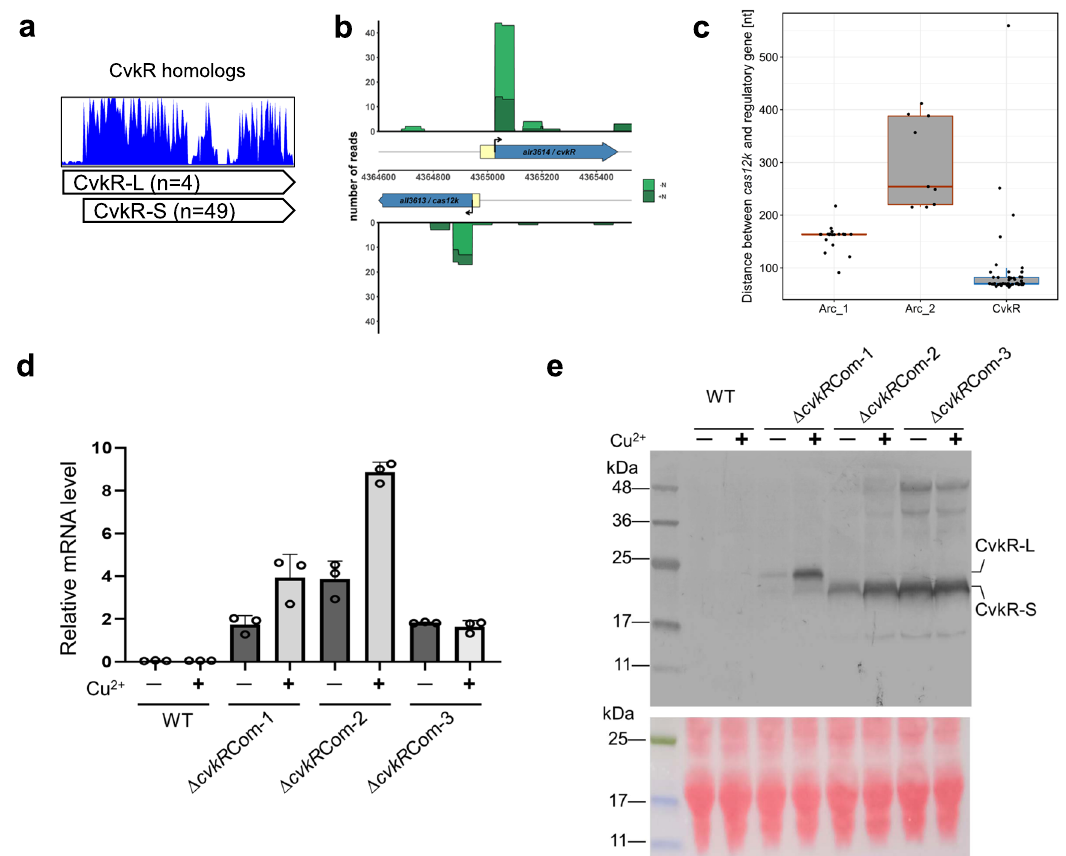
Fig. 3 | Leaderless expression of cvkR genes. a Deduced amino acid sequence alignment of 53 MerR-family CvkR homologs. The sequences of the MerR-family CvkR homologs for the multiple sequence alignment were recovered from public databases and are available in Supplementary Data 1. The sequences were aligned using MAFFT 87 and visualized with UGENE 88 . b Differential RNA sequencing data 28 indicate that the TSSs of cvkR and cas12k were located internal to the NCBI- annotated coding sequences under nitrogen repletion (dark green) and 8h of nitrogendepletion(lightgreen).Yellow boxes indicate the correspondingsections not used in translation. Data shown as primary read coverage mapped to the cor- responding genomic region. Each TSS is represented by an arrow. c Distances between the cas12k effector protein and regulator genes are plotted according to